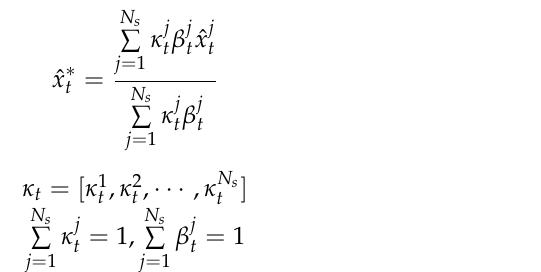
Figure 5. The block diagram of the proposed